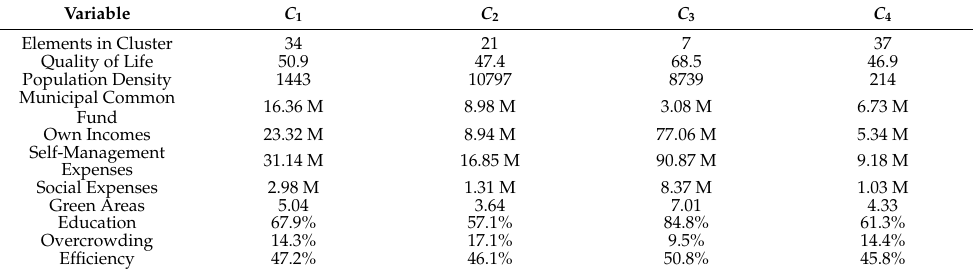
Table 13. Summary on features and variables per